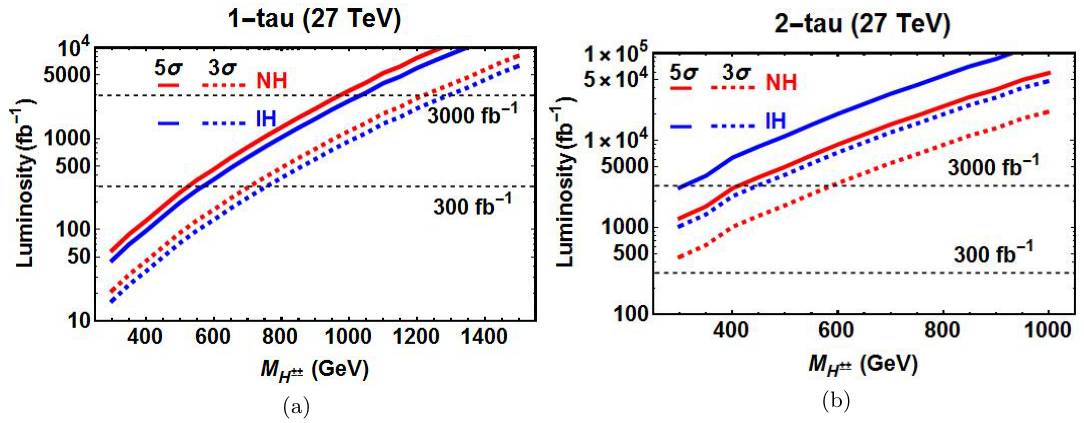
Figure 7 . Integrated luminosity versus M (cid:28) (cid:6) ‘ (cid:6) ‘ (cid:7) ‘ (cid:7) (a) and ‘ + (cid:28) + ‘ (cid:0) (cid:28) (cid:0) (b) with (cid:28) (cid:6) ! (cid:25) (cid:6)